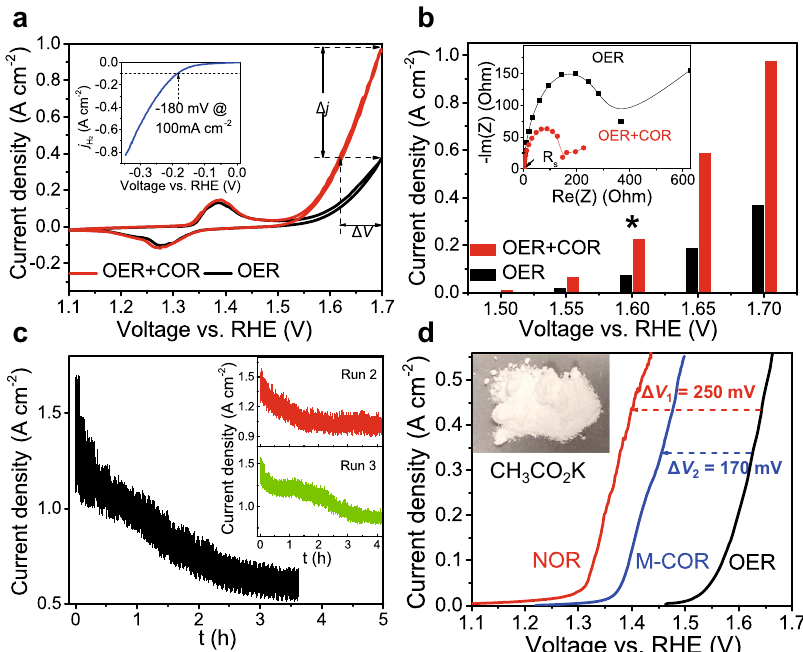
Fig. 3 Electrochemical characterization. a Cyclic voltammograms of anodic reactions at scan rate of 10 mV s − 1 in 1.0 M KOH before (OER; black curves) and after adding 33.3 mg L − 1 of chitin (OER + COR; red curves). Δ j labels the current density difference at 1.7 V vs. RHE, and Δ V labels the potential difference at 0.4 A cm − 2 . Inset: Linear sweep voltammograms of HER using Ni 2 P/NF catalyst, where the potential for 100 mA cm − 2 is labeled. b Comparison of current density at various potential in 1.0 M KOH solution with (red bars) and without (black bars) 33.3 mg L − 1 chitin. Inset: the corresponding electrochemical impedance spectra (EIS) at open-circuit potential. *labels the voltage where the faradaic ef fi ciency of oxygen evolution is characterized in Supplementary Fig. 10. c Consecutive three runs (black, red, and green curves represent the fi rst, second, and third run, respectively) of chitin oxidation reaction (COR) in 1.0 M KOH with 33.3 mg L − 1 chitin at a constant potential of 1.7 V vs. RHE. Inset: chronoamperometry curves of the second (upper) and third (lower) run. d Linear sweep voltammograms of anodic reactions at 5 mV s − 1 in 1.0 M KOH (OER; black curve) and at the condition of containing 2.2 g L − 1 N-acetyl glucosamine (red curve labeled with NOR) and 3.5 g L − 1 milled chitin (blue curve labeled with M-COR). Arrow indicates the shift of potential after adding the corresponding biomass. Inset: a picture of 436 mg of oxidation product potassium acetate (CH 3 CO 2